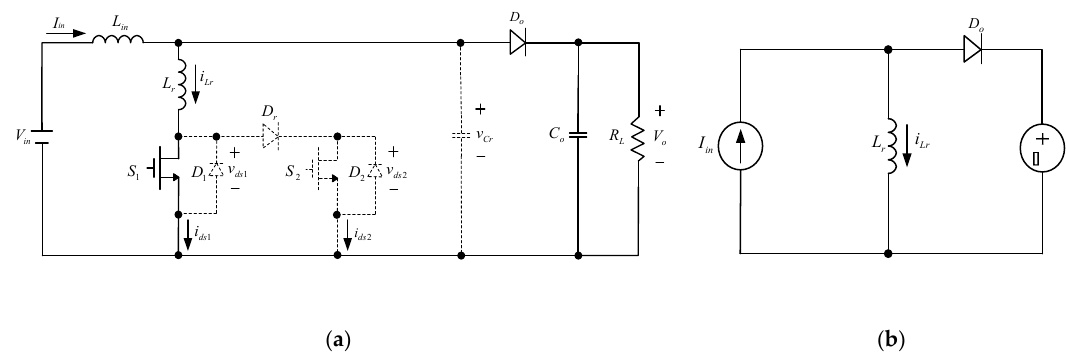
Figure 8. ( a ) Current flow in state 5; ( b ) Equivalent circuit of ( a ).